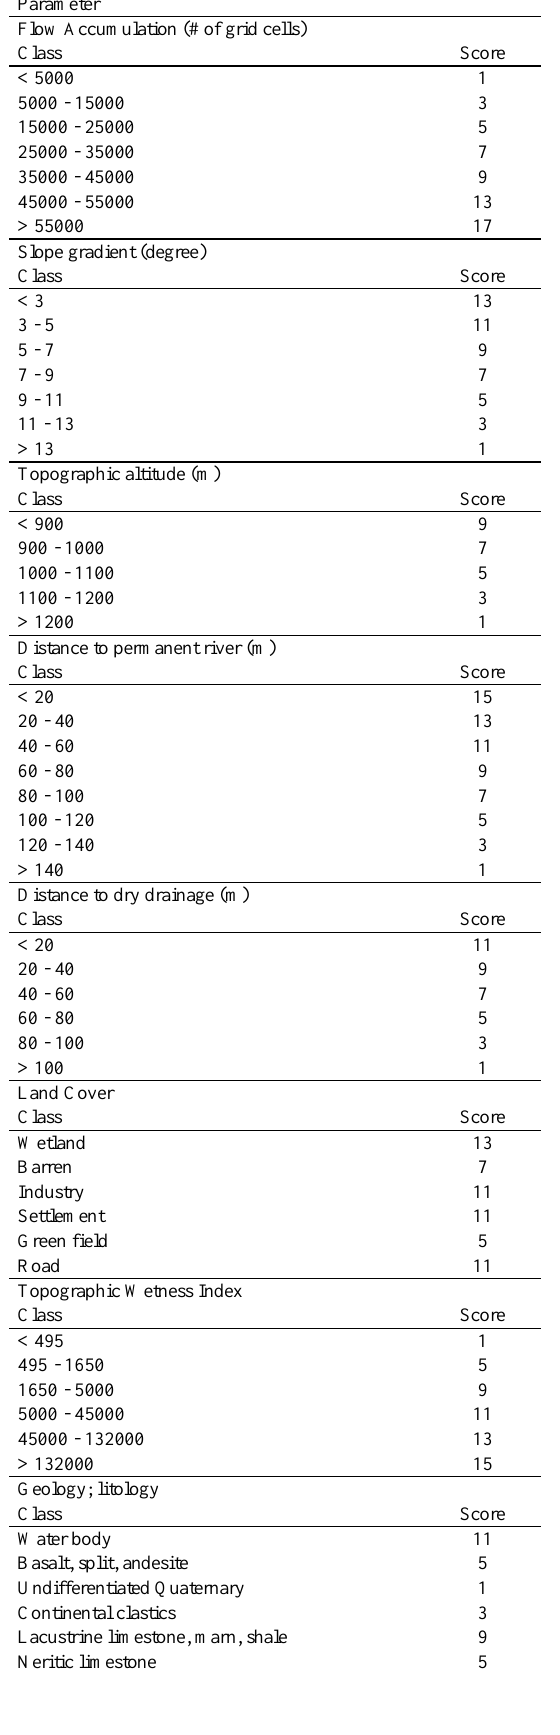
Table 1. The parameters, their classes, and the parameter scores given by the expert for flood susceptibility.